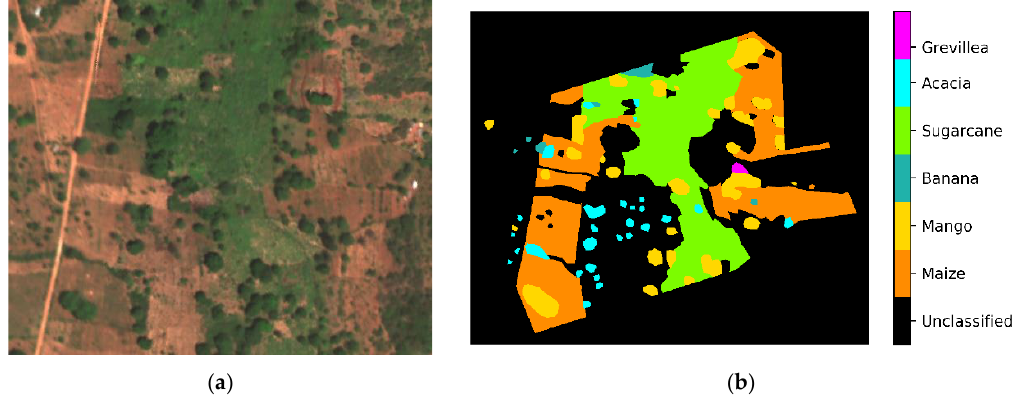
Figure 1. A false-color image over an agricultural field in the Taita Hills data set ( a ) and the related ground truth ( b ).